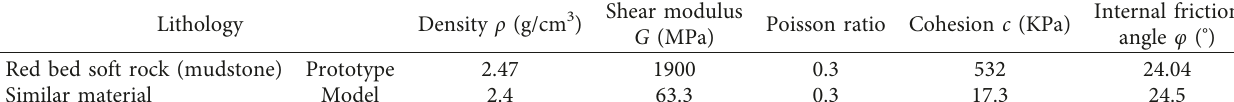
Table 4: Main physicomechanical parameters of prototype and model materials.